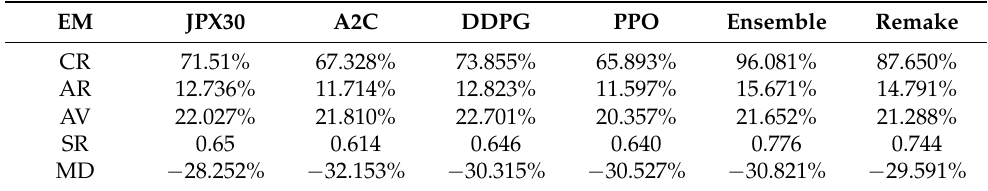
Table 3. Average performance of five RL-based agents on top 30 JPX Stocks from 4 January 2016 to